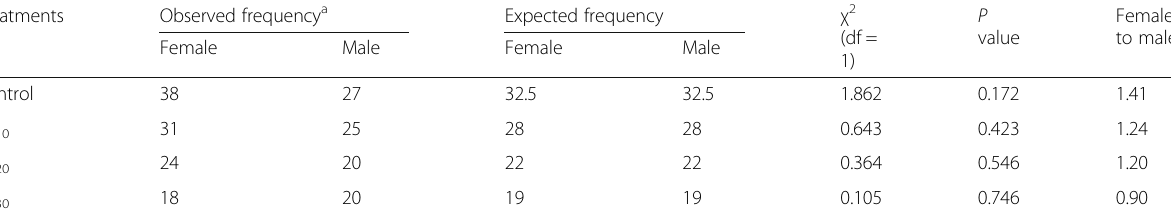
Table 3 Sub-lethal effects of Metarhizium anisopliae (DEMI 001 strain) on sex ratio of Tuta absoluta tested by χ 2 goodness-of-fit to a 1:1 (female to male) ratio